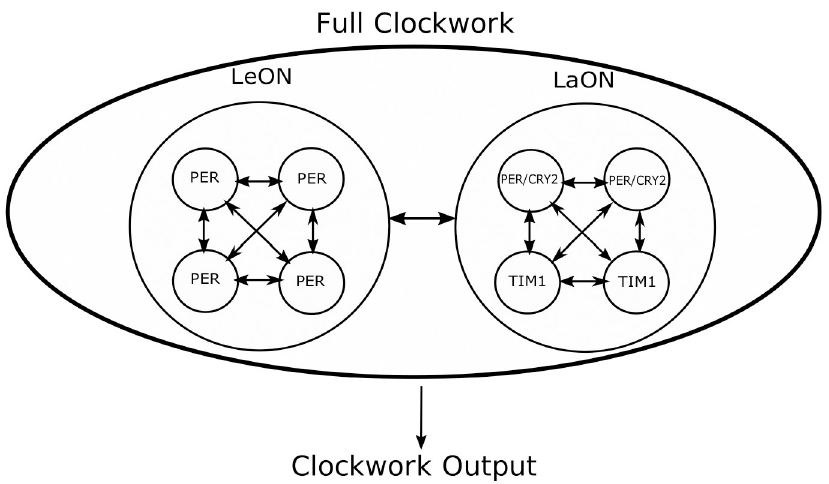
Fig 12. Two circadian oscillator networks with different molecular clockworks per accessory medulla control locomotor activity rhythms of the Madeira cockroach. The lead oscillator network (LeON) with a shorter period and the lag oscillator network (LaON) with a longer period, each consist of four single oscillator neurons. Both networks synchronize with each other and, together, they control locomotor activity rhythms.